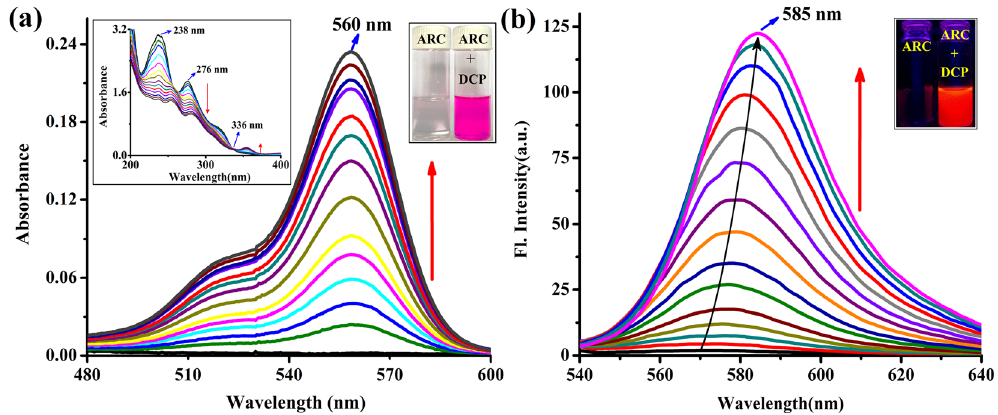
Figure 2. ( a ) UV-vis absorption spectra of ARC (1 µ M) upon gradual addition of DCP upto 1.1 equiv. in H 2 O-CH 3 CN (10:1, v/v). [Inset: left- UV-vis spectra of the region 200–400 nm, right- photograph of visual color changes of ARC and ARC + DCP complex in aqueous medium] ( b ) Fluorescence emission spectra ( λ ex = 520 nm) of ARC (1 µ M) toward DCP at varied concentrations (0, 0.01, 0.05, 0.10, 0.15, 0.20, 0.30, 0.40, 0.50, 0.60, 0.70, 0.80, 0.90, 1.0, 1.05, 1.10 µ M) in H 2 O-CH 3 CN (10:1, v/v). [Inset: Fluorescence color changes of ARC and ARC + DCP complex in aqueous